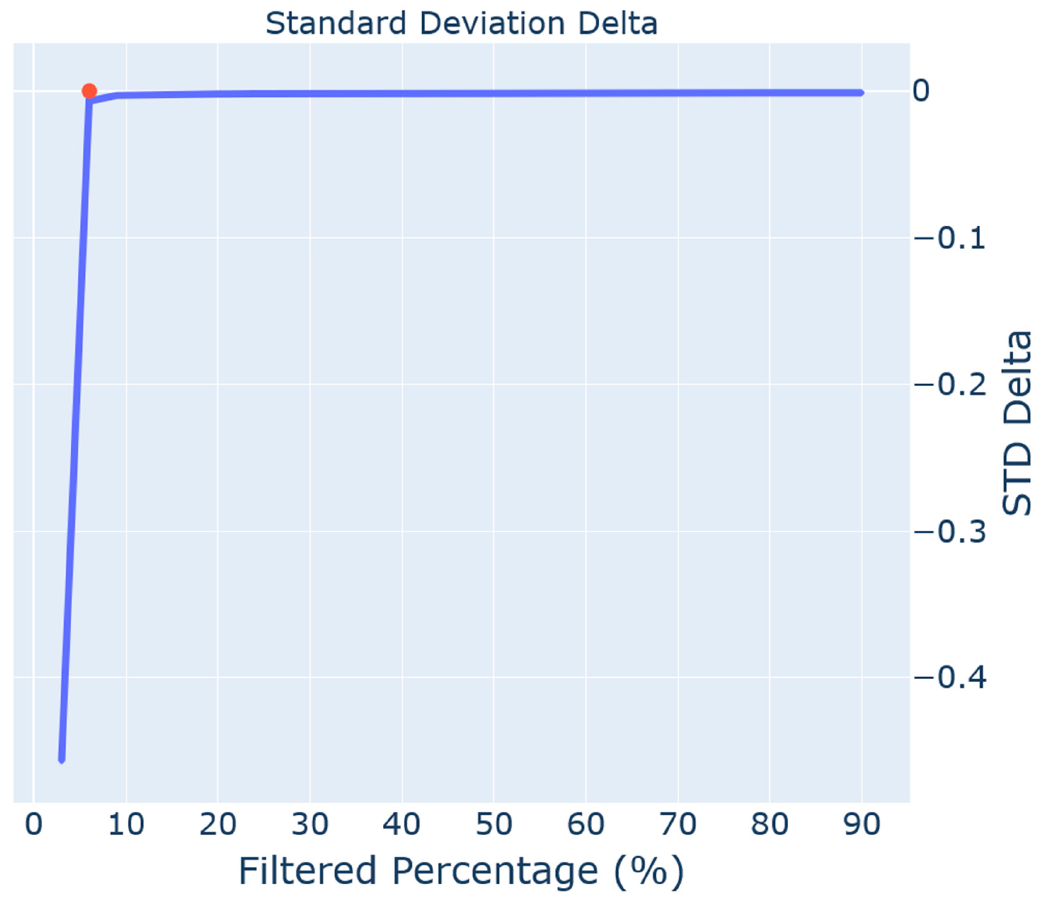
Figure 4. Ideal STD delta graph after data reduction process, with a red dot to represent the intercept of the linear sections.